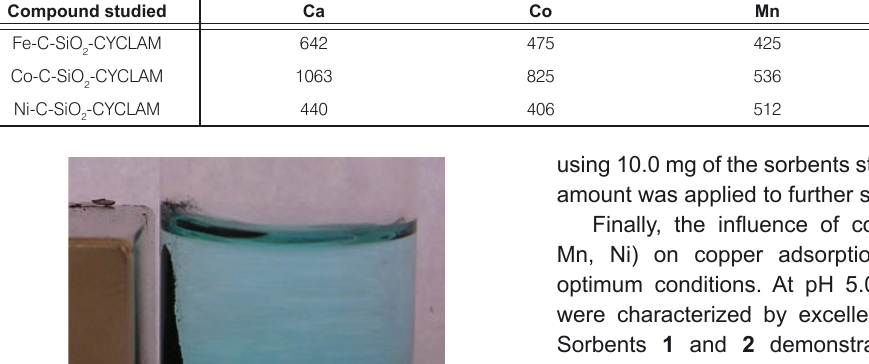
Table 2. Copper(II) selectivity coefficients with respect to other metal ions (